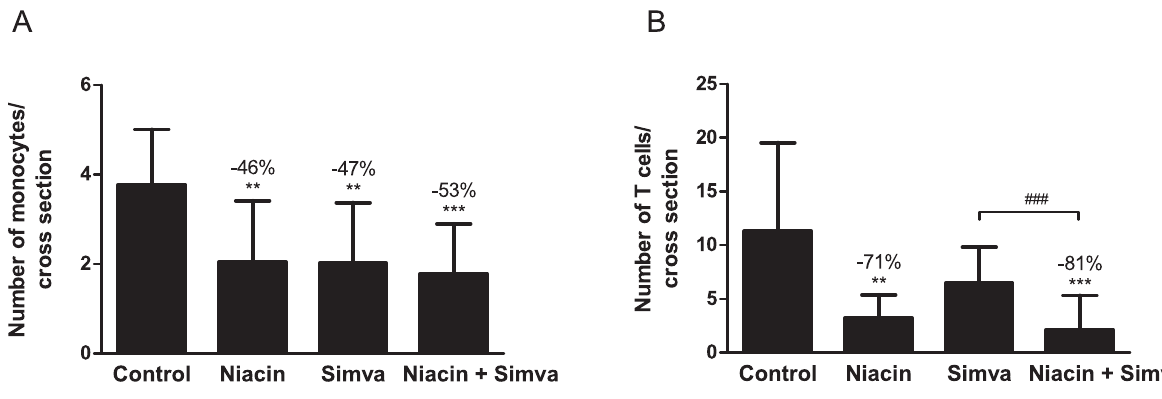
Figure 6. Effect of niacin, simvastatin and their combination on monocyte adhesion and T cell number. The number of monocytes adhering to the endothelium (A) and the number of T cells in the aortic root area (B) were determined per cross section. (Simva, simvastatin; values are means 6 SD; n=15 per group; **P , 0.01; ***P , 0.001 as compared to control; ### P , 0.001 as compared to niacin + simvastatin).